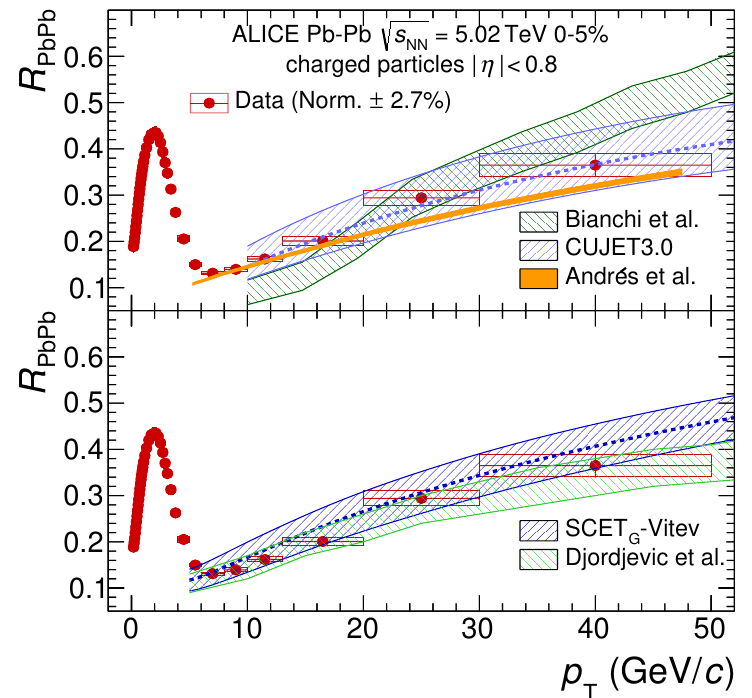
Figure 8 . The charged-particle nuclear modi(cid:12)cation factor measured in the 0{5% most central p Pb-Pb collisions at s NN = 5 : 02 TeV in comparison to model predictions [55{58] (lower panel) and [59{62] (upper panel). The red boxes around data points represent p T dependent systematic uncertainties. The normalization uncertainty of the data ( (cid:6) 2 : 7%) is not part of the uncertainties of the plotted data